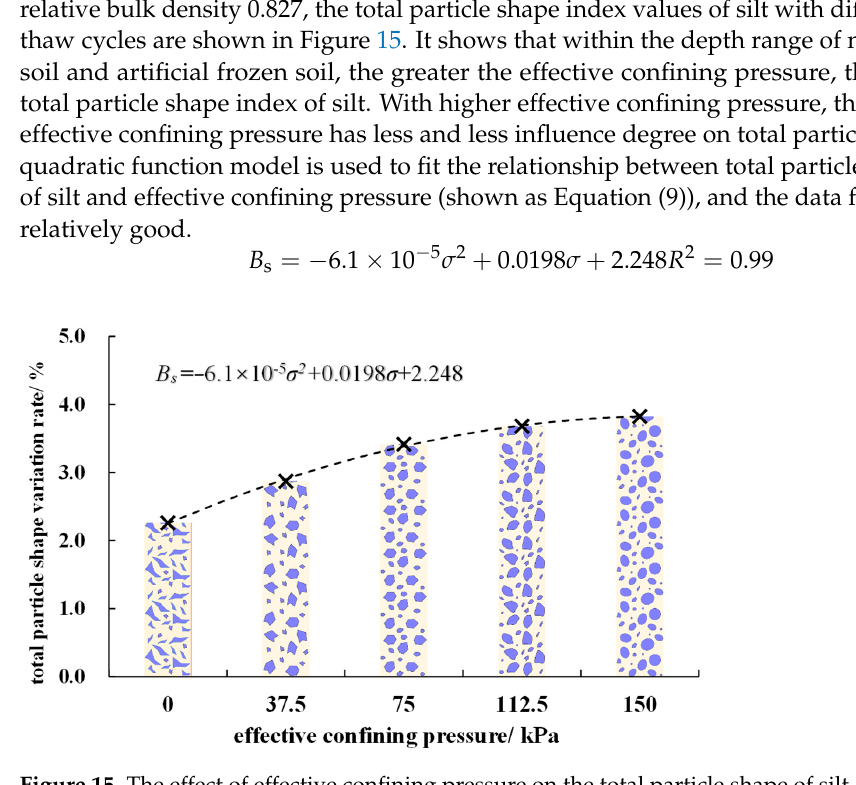
Figure 14. The effect of effective confining pressure on the total particle size of silt.